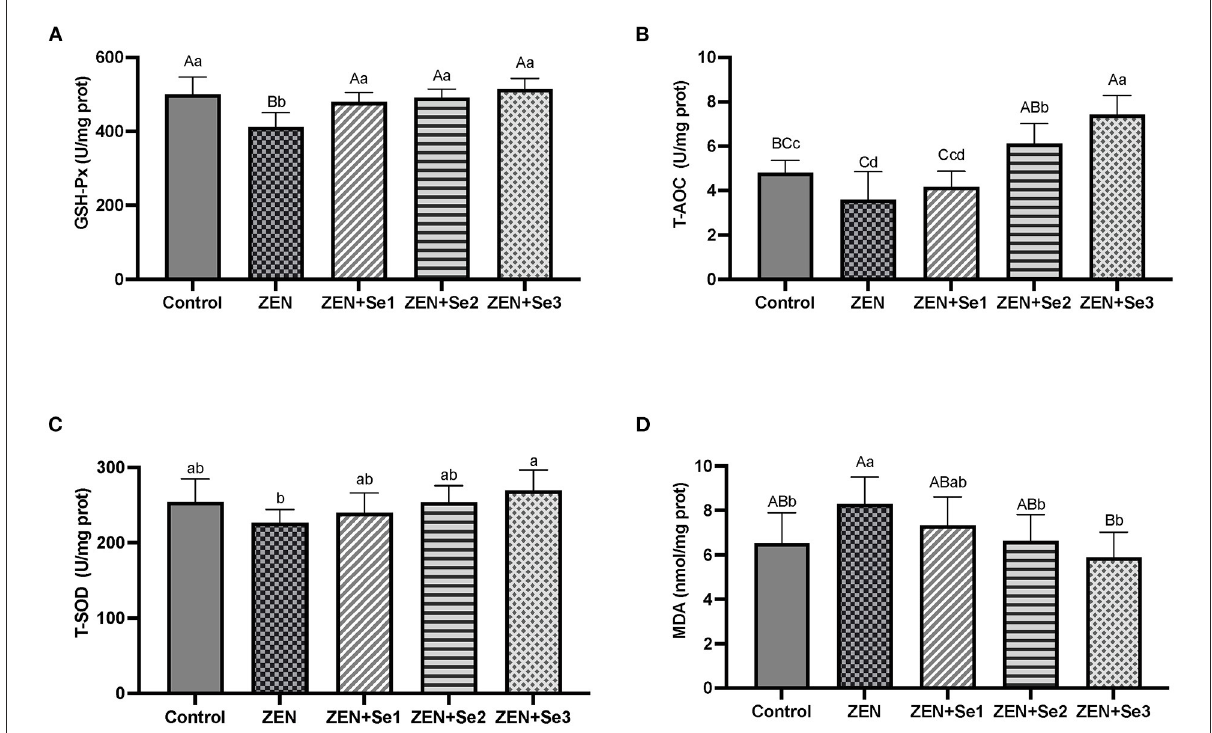
FIGURE2 Effects of SC on liver levels of different parameters induced by ZEN in mice: (A) GSH-Px activity; (B) T-AOC level; (C) T-SOD activity; (D) MDA content. Different capital letters (lowercase letters) in the column chart indicate a significant difference at the 0.01 (0.05) level.